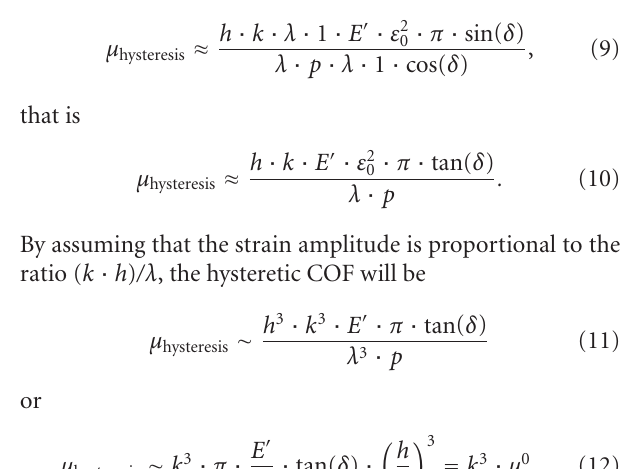
the complex and the storage modulus is E ∗ = E (cid:4) / cos( δ ). By inserting this in (8), the hysteretic COF will